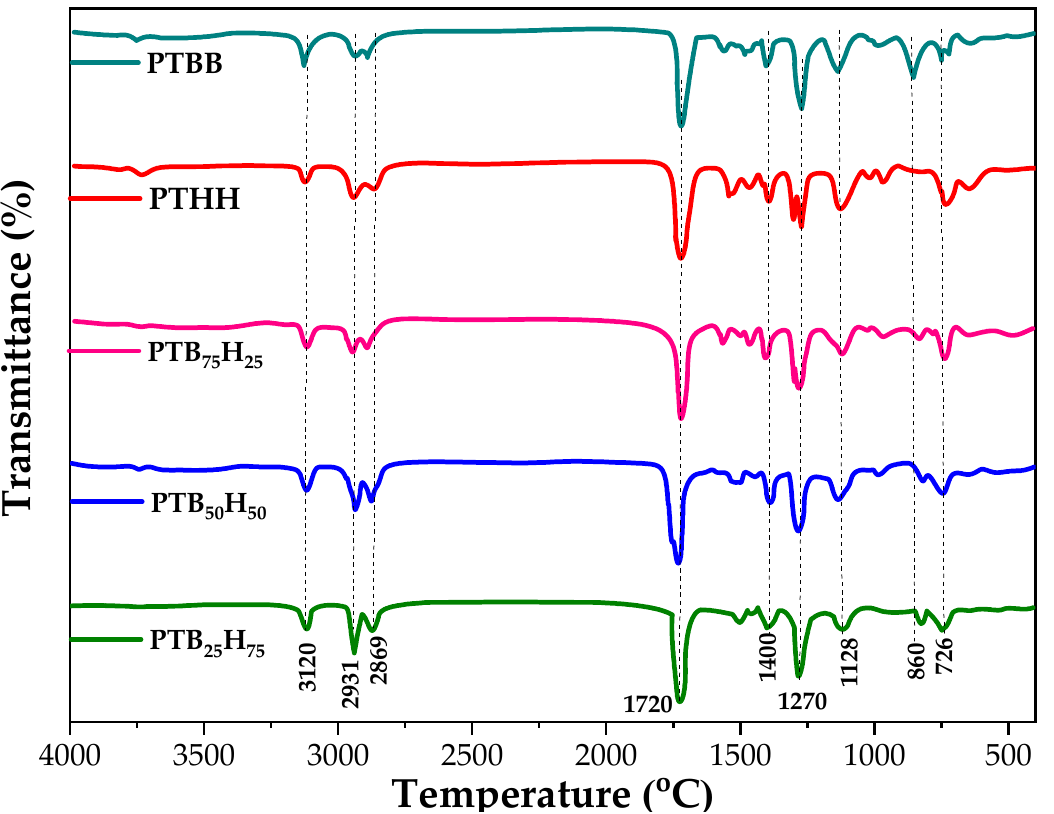
Figure 1. FTIR spectra of the homologs poly(1,4-bis(2-hydroxyethyl)benzene thiophenedicarboxylate) (PTBB), poly(hexylene thiophenedicarboxylate) (PTHH), and poly(hexylene 2,5-thiophenedicarboxylate-co-bis(2-hydroxyethoxybenzene) (PTB x H y )